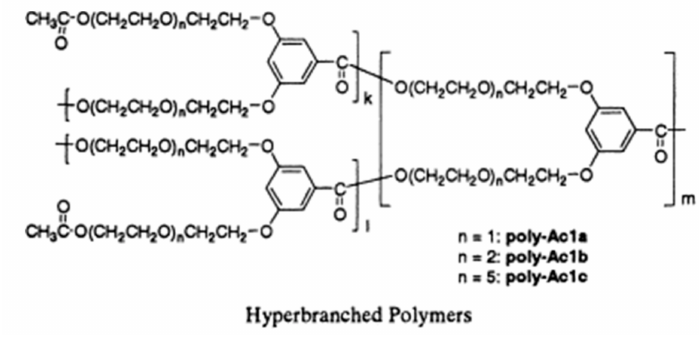
Figure 3. Chemical structure of hyperbranched polymers